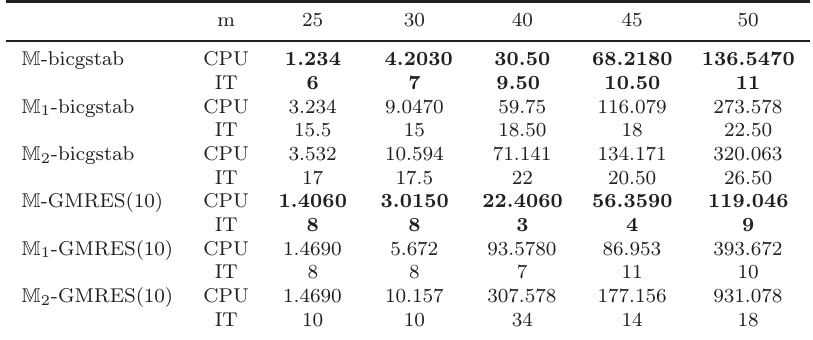
Table 2. Solution time in seconds and number of iterations of GMRES and BiCGSTAB iteration methods with preconditioner M presented in this paper and preconditioners M 1 , M 2 proposed in [19] for µ = 10 , α = 0 . 5 and β = 2 . 2